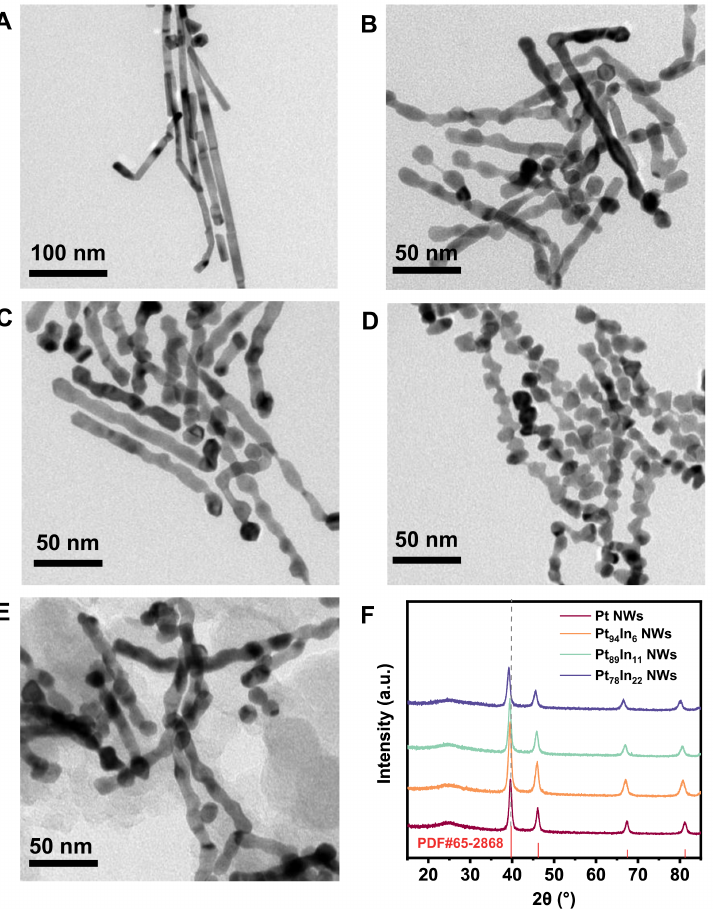
Figure 1. TEM images of ( A ) Pt NWs, ( B ) Pt 94 In 6 NWs, ( C ) Pt 89 In 11 NWs, ( D ) Pt 78 In 22 NWs. ( E ) TEM image of carbon-supported Pt 89 In 11 NWs. ( F ) XRD patterns of Pt and Pt-In NWs.